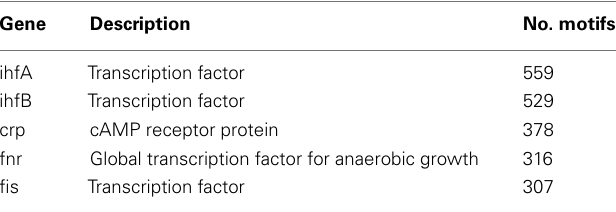
Table 3 |Top five genes in the motif participation